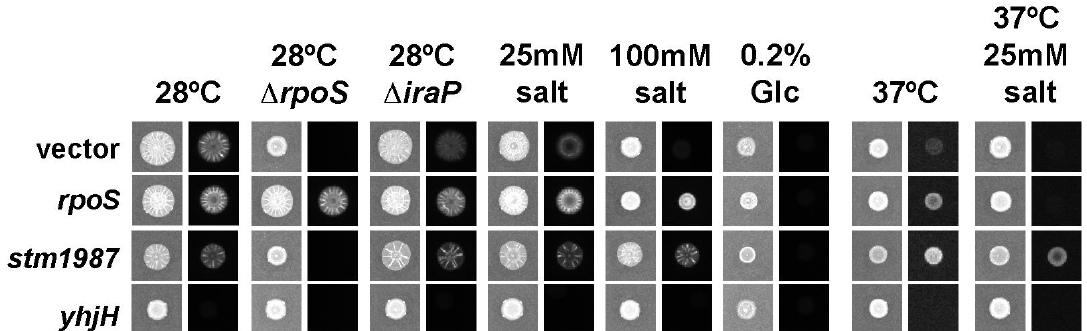
Figure 7. Visualization of S. typhimurium curli expression in response to changing growth conditions. S. typhimurium 14028 wild-type, ∆ rpoS or ∆ iraP reporter strains containing a csgBAC promoter–luciferase fusion were transformed with pBR322 (vector), pACYC / rpos ( rpoS ), pBR322 / stm1987 ( stm1987 ) or pBR322 / yhjH ( yhjH ) plasmids. Cells were inoculated onto T agar or T agar supplemented with 0.2% glucose, 25 mM or 100 mM NaCl and grown at 28 ◦ C or 37ºC. Colony morphology (left column) and luminescence (right column) was recorded after 48 h growth. Control strains containing pACYC were also tested, but the csgBAC expression profiles were similar to strains transformed with pBR322; therefore, only the pBR322 pictures are